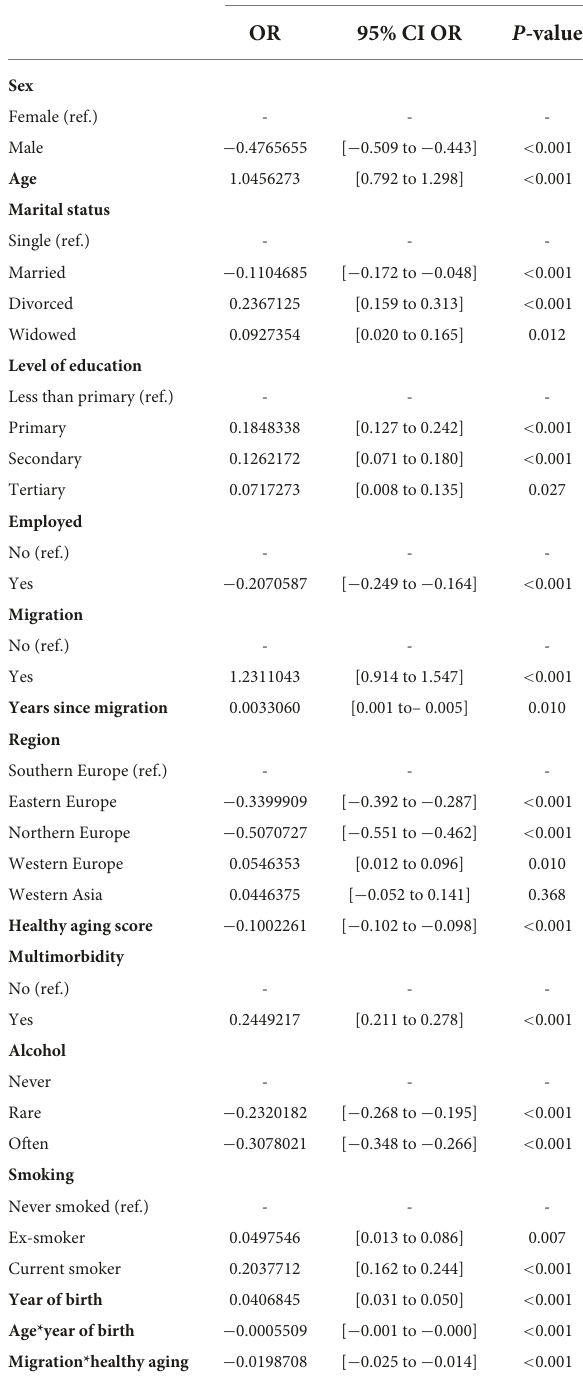
TABLE 2 Results from multivariate logistic regression analyses with late-life depression as an outcome variable in the total sample.